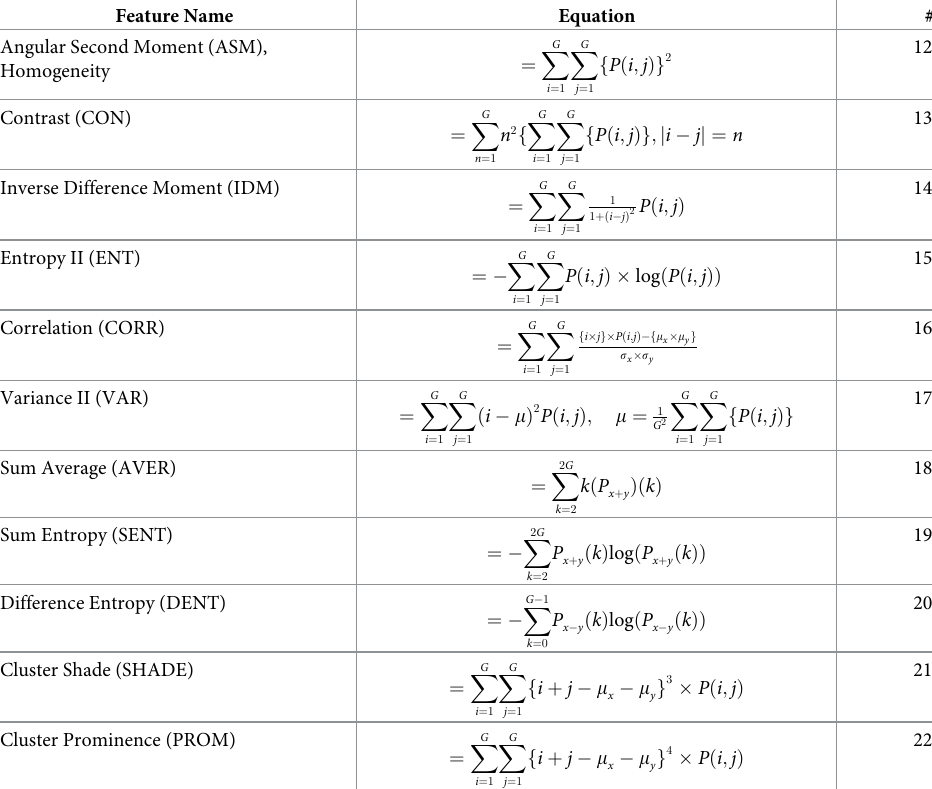
Table 3. Haralick features used for texture analysis.